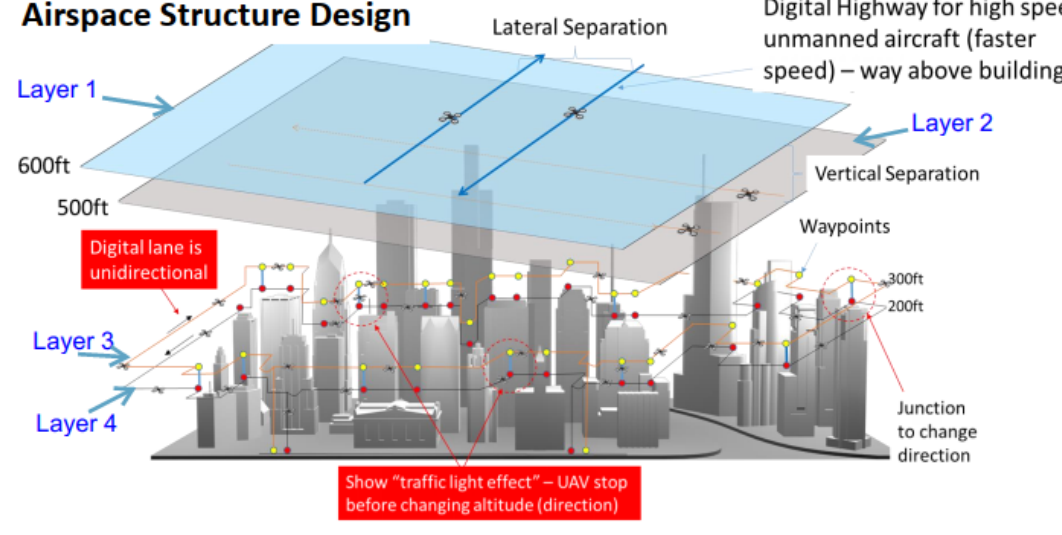
Figure 4. A framework structure for urban airspace management (Kin Huat Low 2017).